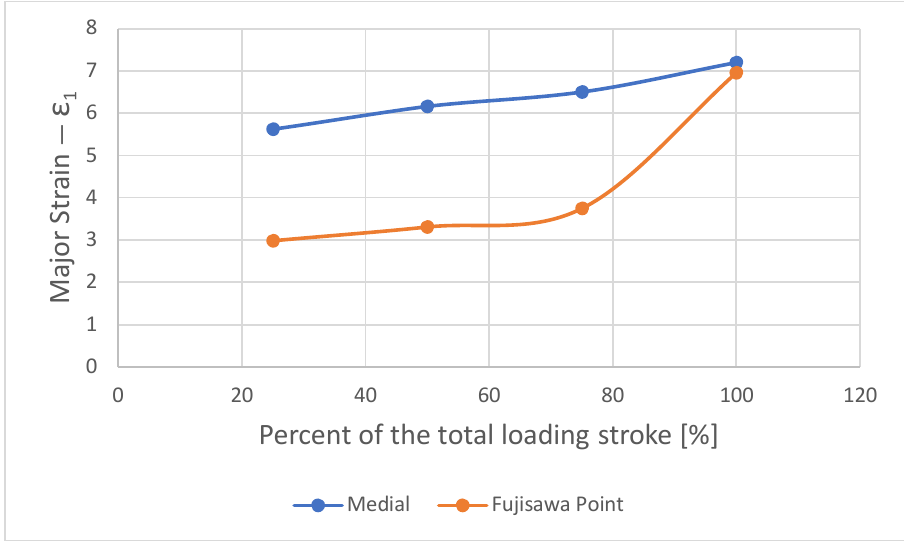
Figure 11. Variations of the major strain ε 1 during medial and offset loading (Fujisawa point).